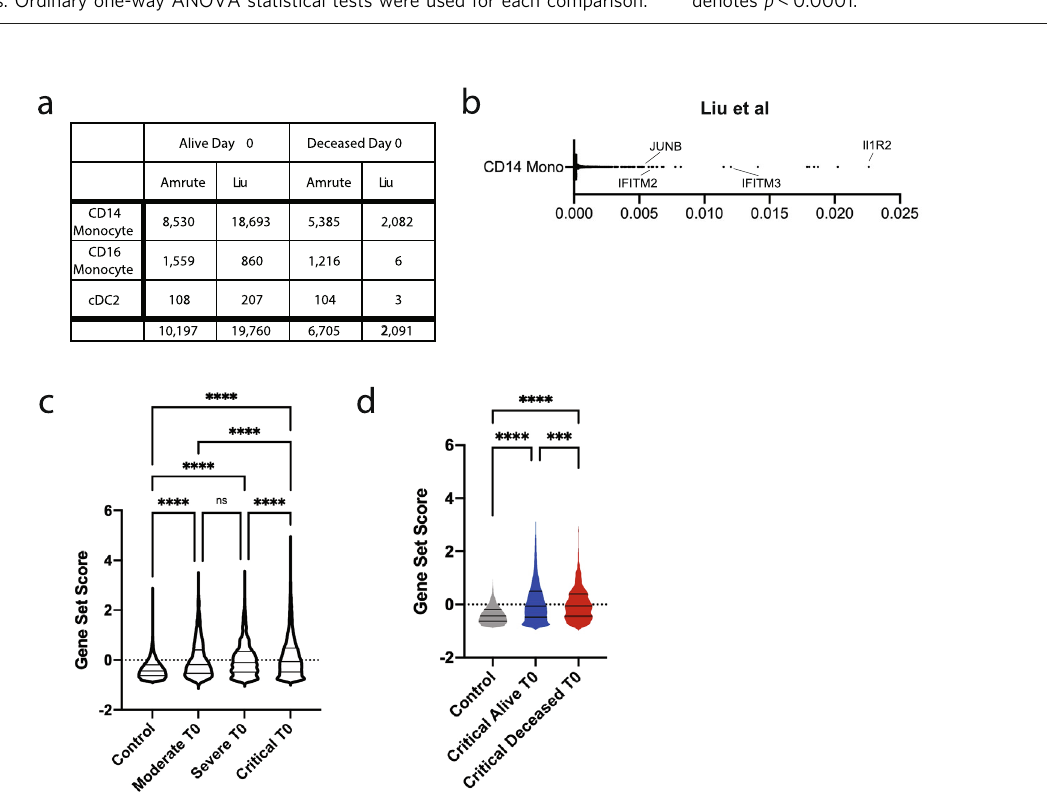
Fig. 4 Innate immune cells dominate early peripheral immune responses and predict survival in critical COVID-19. a UMAP embedding plot of CD14 monocytes, CD16 monocytes, and cDC2 cells for the following sample conditions: Control, Alive day 0, and Deceased day 0. b Hierarchical clustering heatmap of average normalized gene expression for statistically signi fi cant differentially expressed genes (adjusted p -value < 0.05 and log2FC> 0.50) between Control, Alive day 0 and Deceased day 0 CD14 monocytes, CD16 monocytes, and cDC2 cells. UMAP embedding plots and quanti fi cation for Control, Alive day 0, and Deceased day 0 samples for c in fl ammatory activation gene set z -scores, d antigen-presentation gene set z -scores, e ISG set z -scores, and f protein synthesis gene set z -scores from genes in b . All comparisons were statistically signi fi cant ( p < 0.0001) except the ones marked n.s. g Random forest classi fi er model survival prediction accuracy using 3000 highly variable gene normalized counts in all cell types with at least 100 cells. Red boxed cell types are those with a prediction accuracy of >80%. h Ranked feature importance score from random forest classi fi er model with key genes annotated in CD14 monocytes (top), CD16 monocytes (middle), and cDC2 cells (bottom). i Global UMAP embedding plot of the top 100 predictive features in CD14 monocytes, CD16 monocytes, and cDC2 cells for Control (top), Alive day 0 (middle), and Deceased day 0 (bottom). j Venn diagram of overlapping genes from the top predictive features for the CD14 monocytes random forest classi fi er, statistically signi fi cant differentially expressed genes between Alive day 0 and Deceased day 0 CD14 monocytes, and statistically signi fi cant differentially expressed genes between Control and day 0 CD14 monocytes. k UMAP embedding plot from a of Control (left, top), Alive day 0 (left, middle), and Deceased day 0 (left, bottom) for four overlapping genes